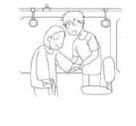
Figure 8. Example of materials used in the Experiment 3a.